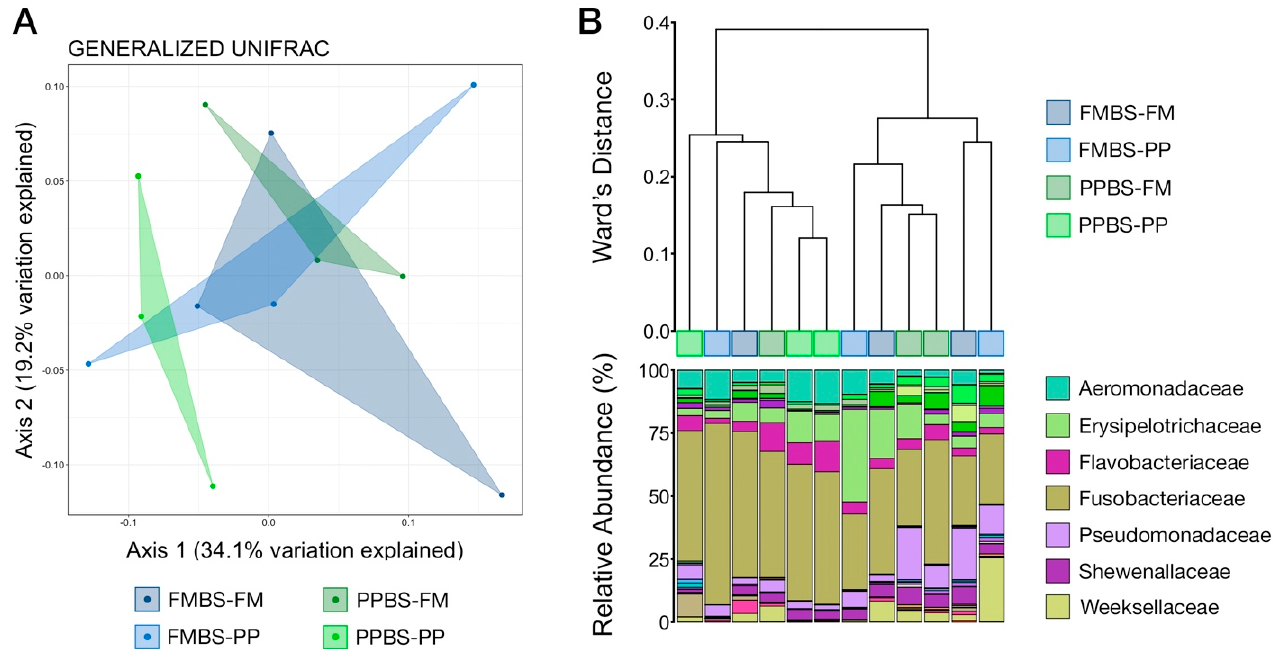
Figure 4. ( A ) Principal coordinates analysis (PCoA) of unweighted Unifrac distances relating the variation in microbial community composition between samples from the final weights time point (48 dph). There was no significant difference detected in community composition between groups (PERMANOVA, n = 3, p > 0.05). ( B ) Hierarchal clustering showing the relatedness of gut microbial communities from 48 dph based on generalized UniFrac distances. The barplot demonstrates the relative abundance of microbial families and the seven most abundant families are displayed in the legend. Abbreviations: dph, days post hatch; FM, fishmeal broodstock; SBM, soybean meal broodstock; FMBS-FM, fishmeal broodstock with fishmeal programming; FMBS-PP, fishmeal broodstock with soybean meal programming; PPBS-RM, soybean mean broodstock with fishmeal programming; PPBS-PP, soybean meal broodstock with soybean meal programming.